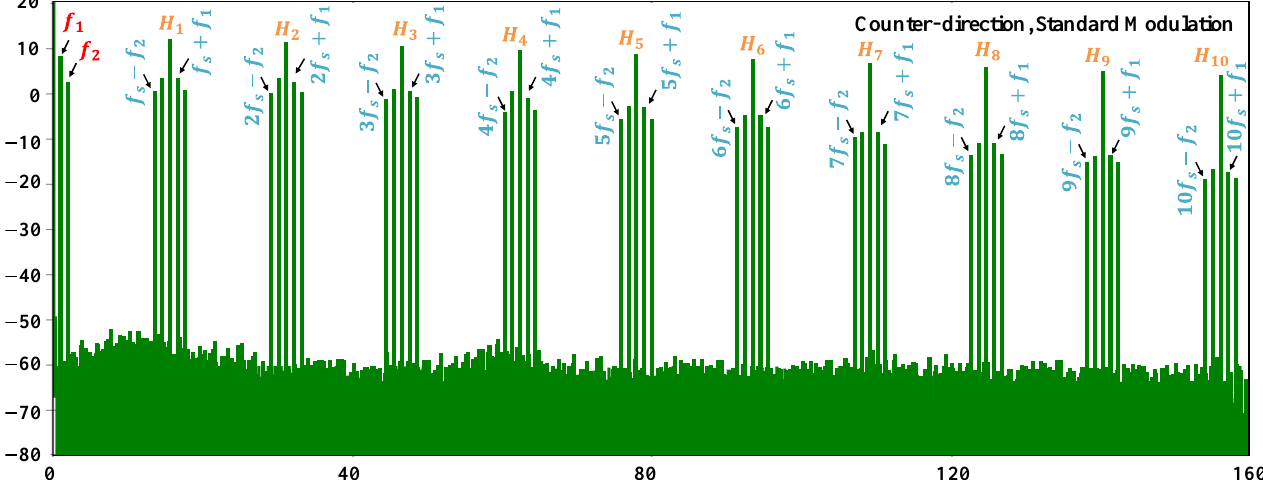
Figure 9. Electrical spectrum of the up-converted signal, which represents the electrical power in dBm as a function of frequency in GHz, at 𝑛𝑓 𝑠 ± 𝑓 𝑚 at the SOA-MZI output for the standard modulation in the counter-direction. The frequencies of the two input signals are 𝑓 1 = 1 GHz and